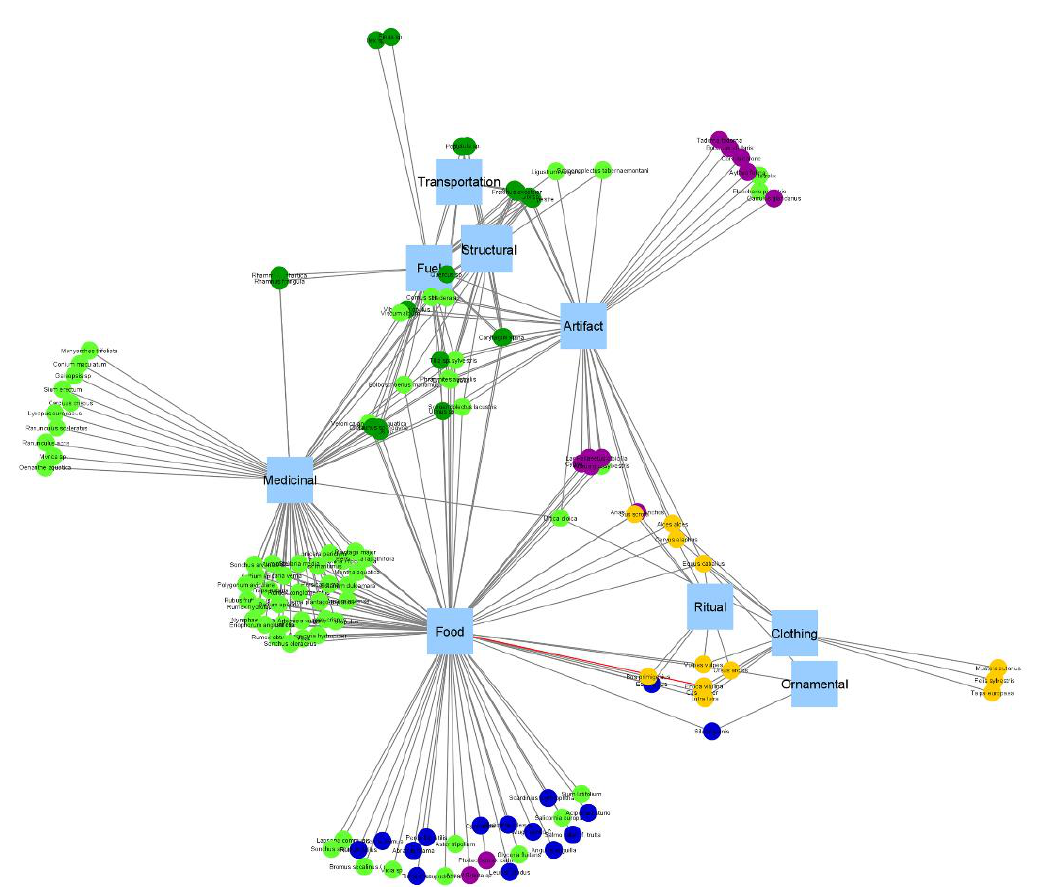
Figure 10. Visualization of network structure for the ‘winter habitat’.